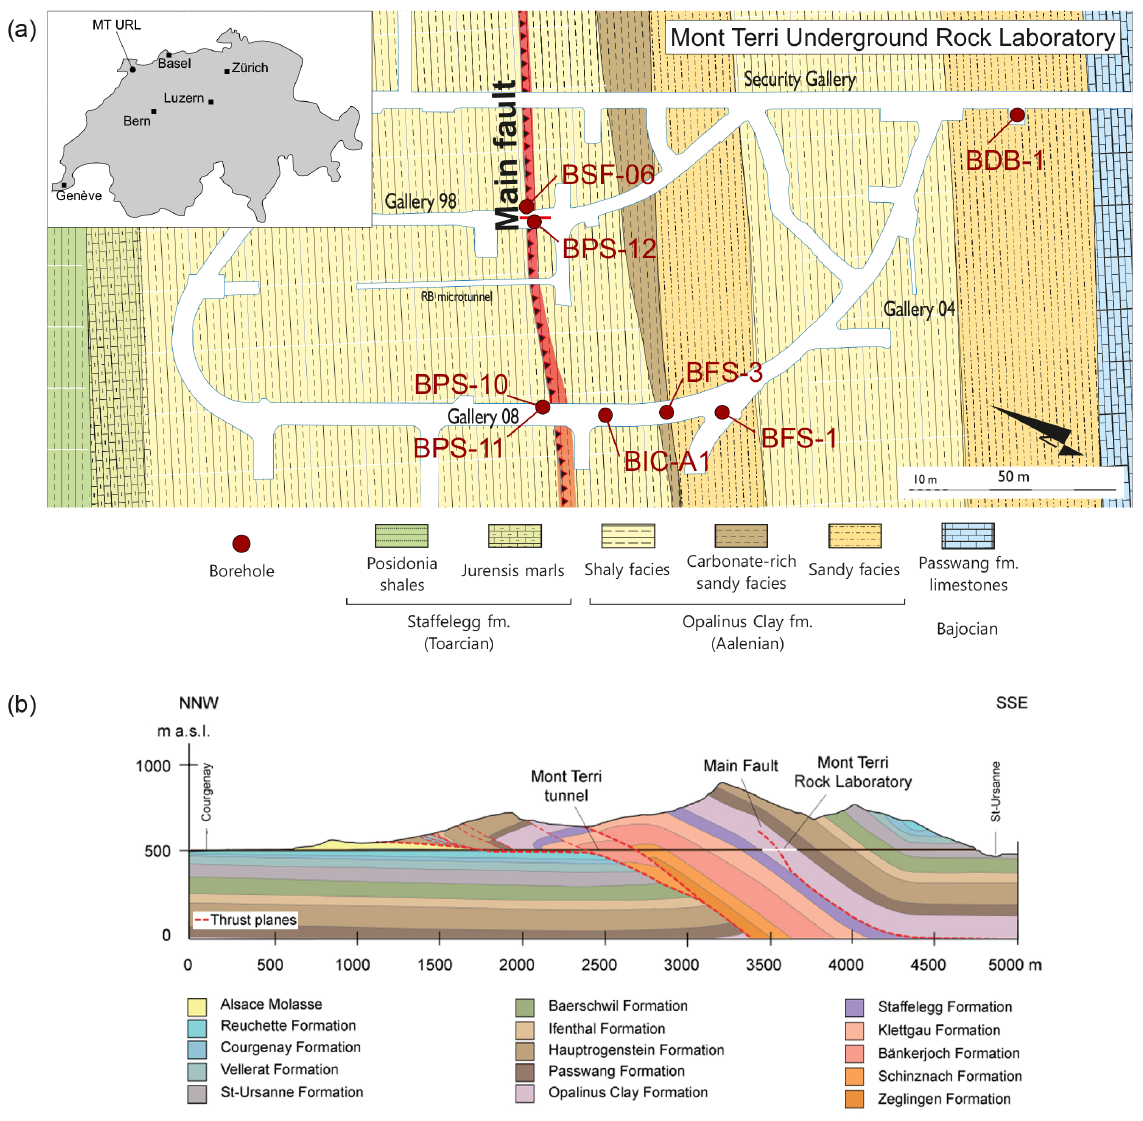
Figure 1. Geology of the Mont Terri Rock Laboratory (CH). (a) Outline and facies map (plan view); borehole locations indicated. (b) 2-D balanced cross section after Nussbaum et al.